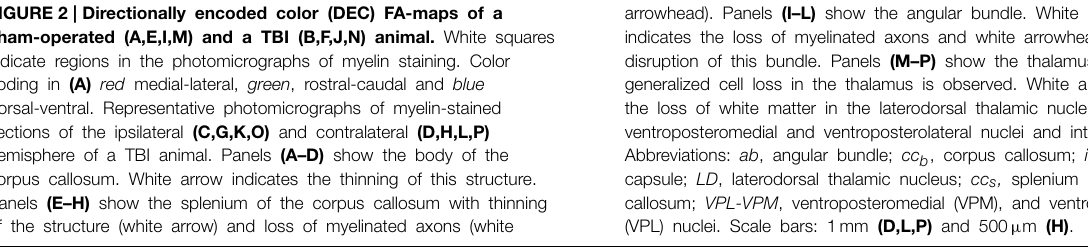
arrowhead). Panels (I–L) show the angular bundle. White arrow indicates the loss of myelinated axons and white arrowhead the disruption of this bundle. Panels (M–P) show the thalamus. In (G) , the generalized cell loss in the thalamus is observed. White arrows indicate the loss of white matter in the laterodorsal thalamic nucleus, ventroposteromedial and ventroposterolateral nuclei and internal